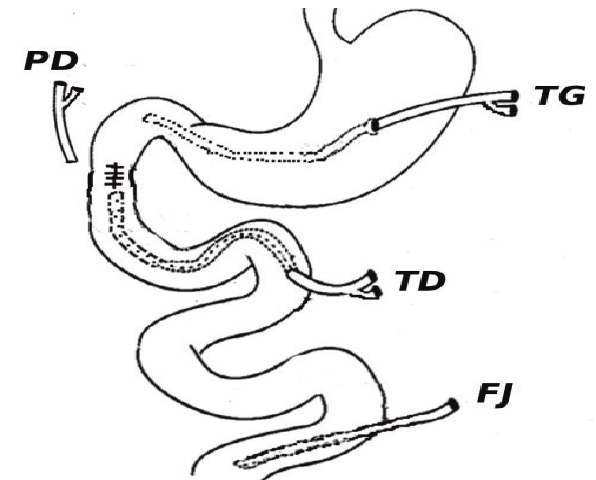
Figure 1. Diagramatic representation of triple tubostomy. TG-Tube Gastrostomy with its tip in the first part of Duodenum. TD- Retrograde